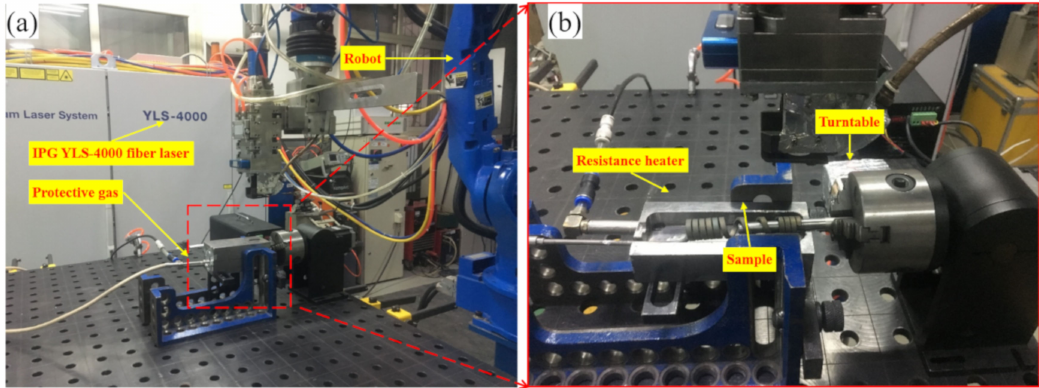
Table 1. Welding parameters used in the fiber laser welding of the socket joint made of NS Mo. Sample Number